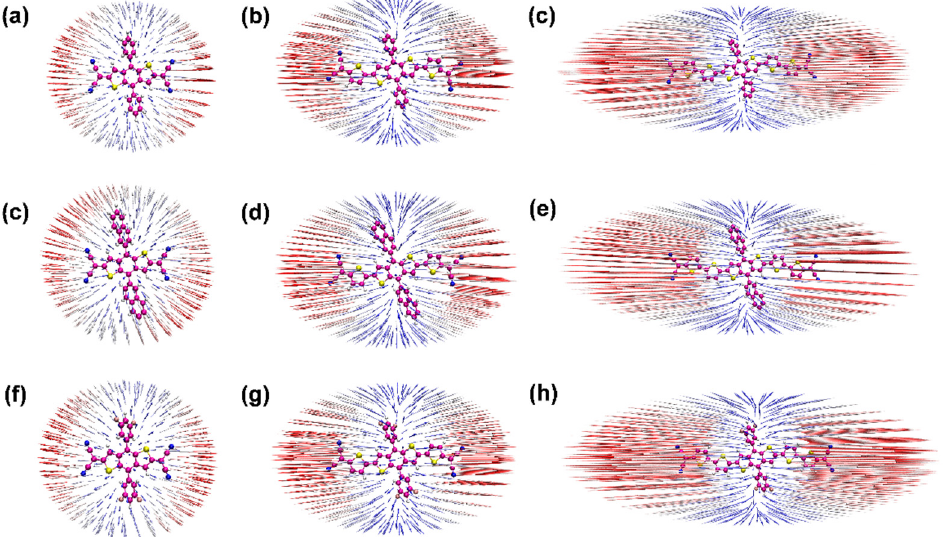
Figure 5. ( a – h ) the anisotropy of the hyperpolarizability of the nine compounds ( 1 – 9 ); the blue and red represent arrow difference in length.